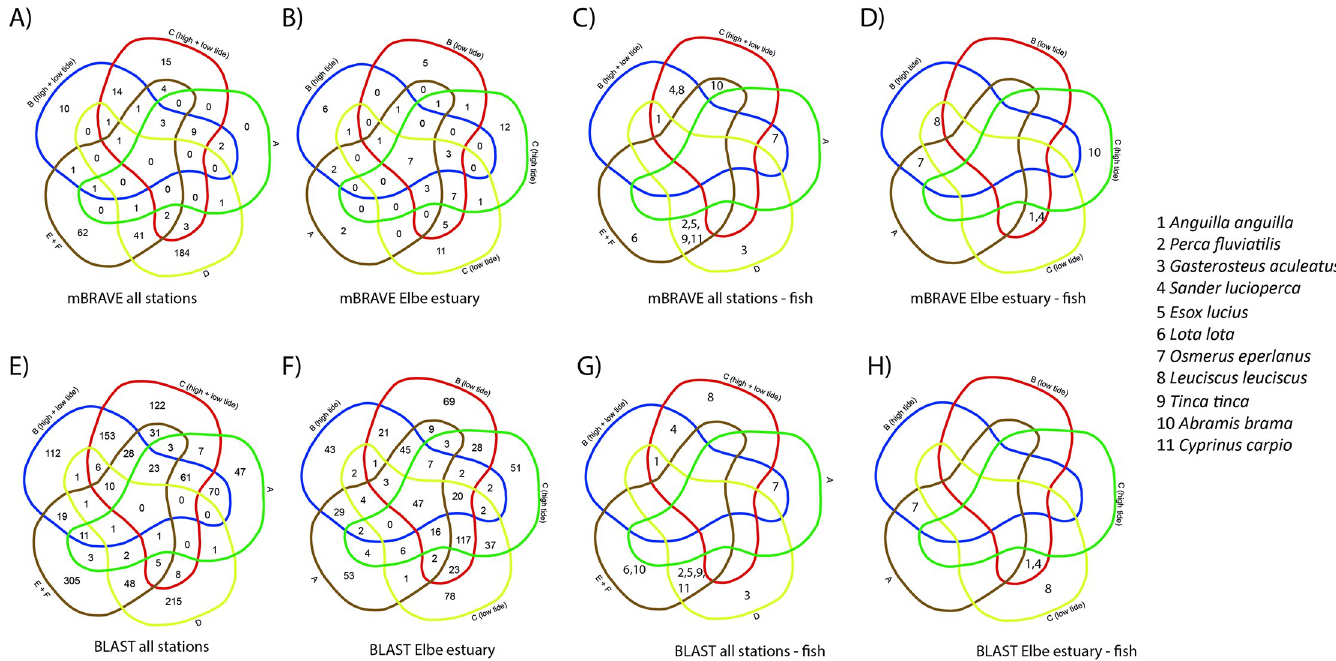
Fig 5. Venn diagrams of OTUs shared between stations. A–D) represent mBRAVE and E–H) BLAST results. A) and E) all Metazoa in all Elbe and lake stations (high and low tide sampling events combined), B) and F) all Metazoa in all Elbe stations with high and low tide events shown separately, C) and G) fish species in all Elbe and lake stations (high and low tide sampling events combined) and D) and H) fish species in all Elbe stations with high and low tide events shown separately. A), B), E), and F) show the number of shared OTUs, whereas in C), D), G) and H) shared fish species are indicated (here each number corresponds to a specific fish species as shown in the